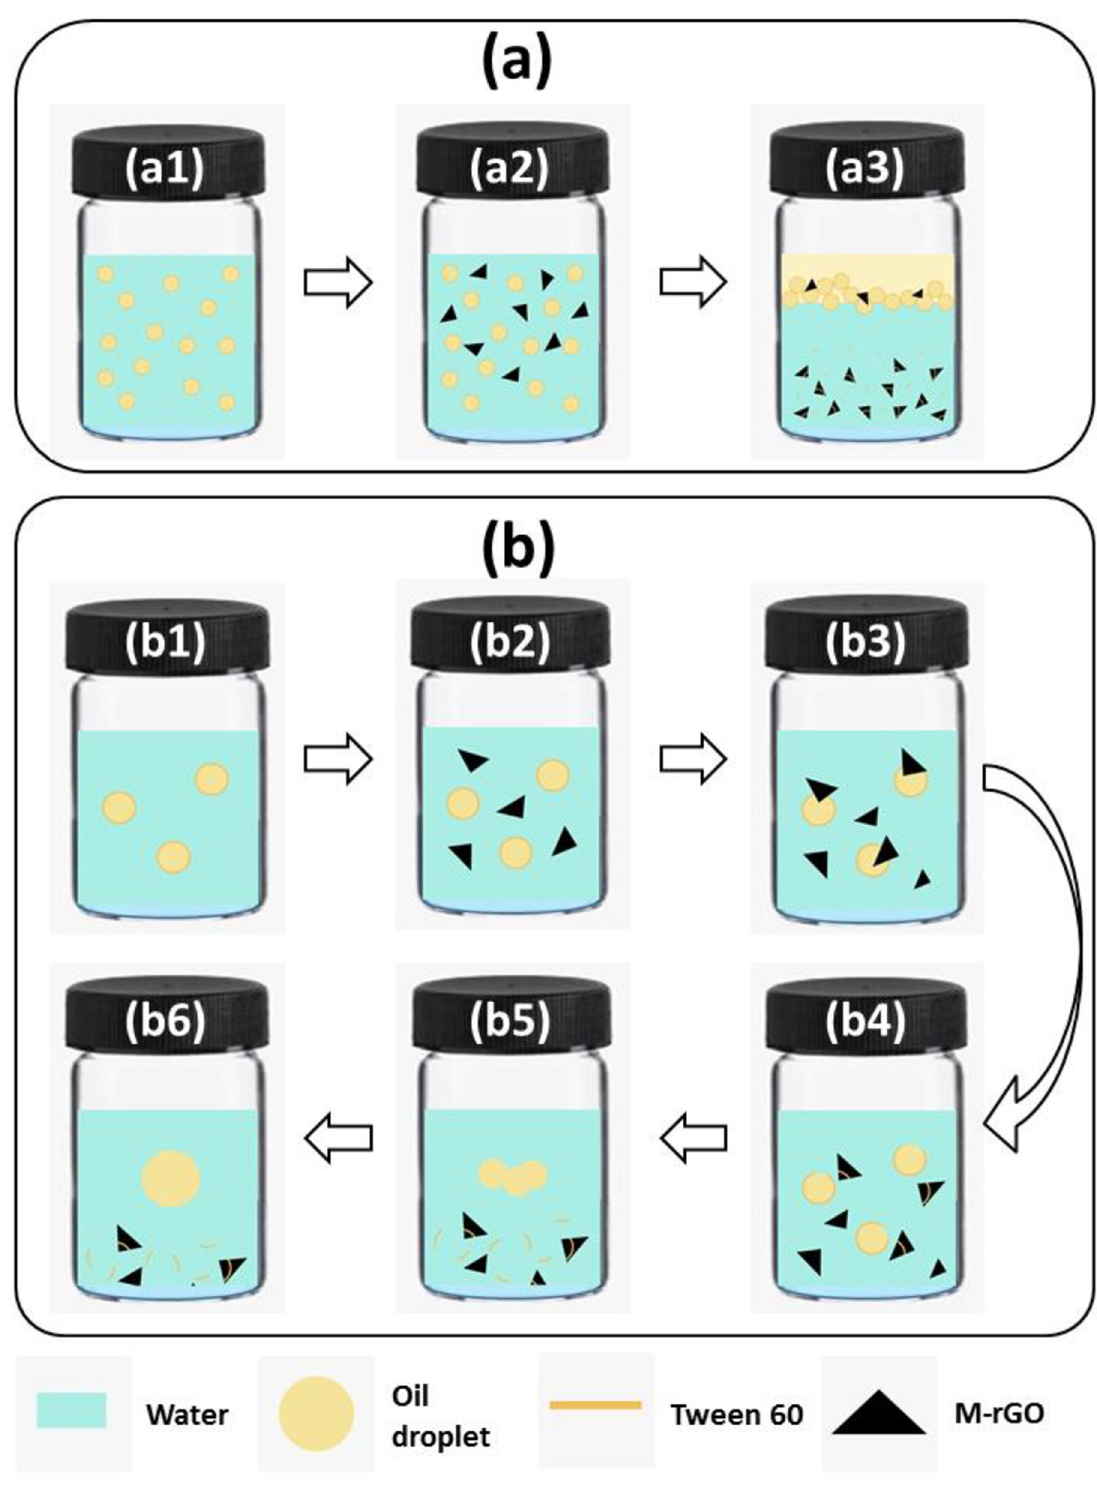
Fig 12. Schematic illustration of (a) the demulsification process and (b) the possible demulsification mechanism.